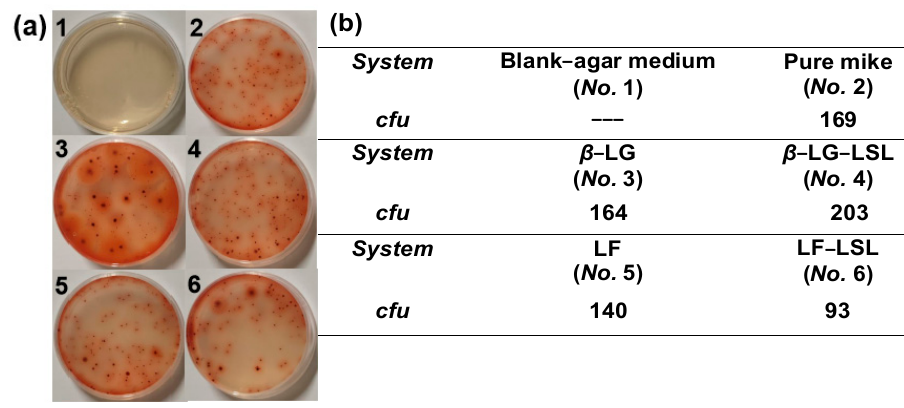
Figure 5. ( a ) The results of the Colony Color Test of β − LG/LF − LSL complex dispersion in milk emulsion at 298.2 K. ( b ) The number of colonies in β − LG/LF − LSL system under milk emulsion.